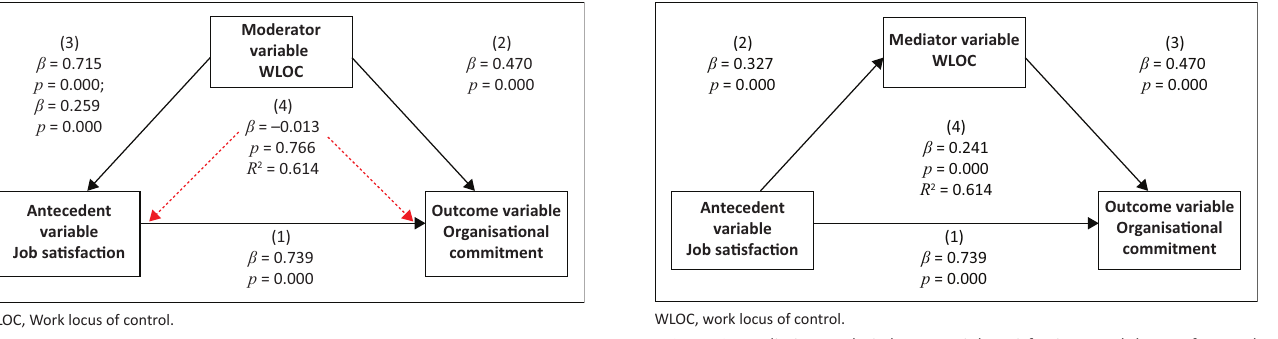
FIGURE 5: Moderation analysis between job satisfaction, work locus of control and organisational commitment. TABLE 2: Status of